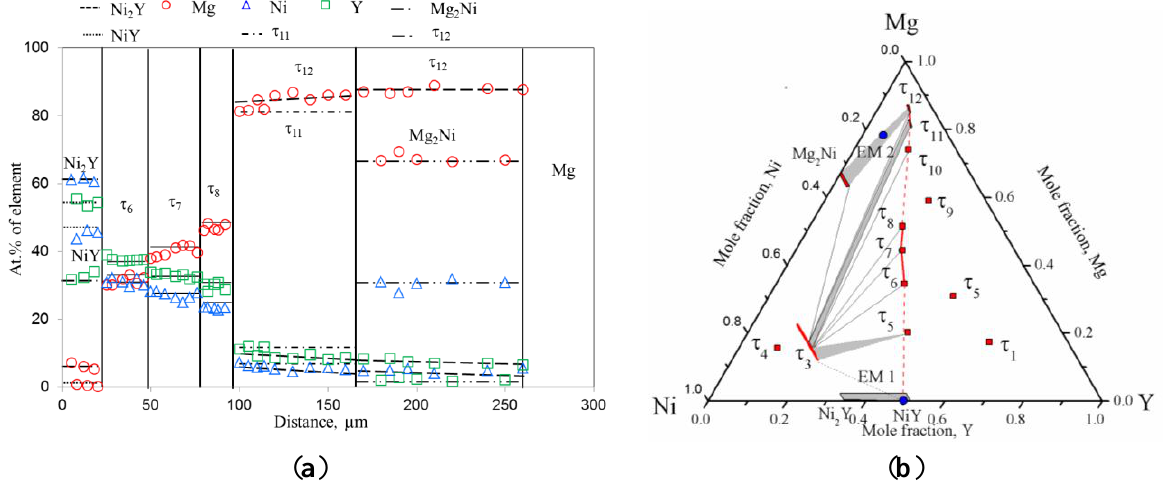
Figure 12. ( a ) Composition profile of the solid–liquid diffusion couple-2 along the line scan shown in Figure 10b; ( b ) Extracted phase equilibria based on the solid-liquid diffusion couple-2 projected on the Mg-Ni-Y Gibbs triangle. Dotted lines indicate expected phase equilibria which are not recognized in this